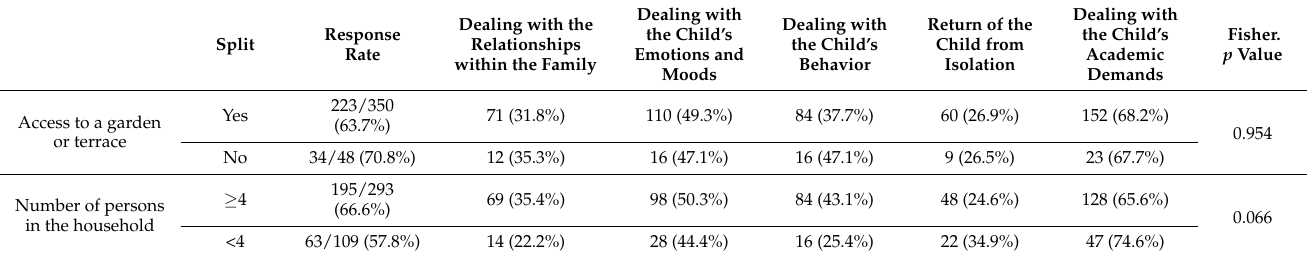
Table 3. Subgroup analysis based on a median split with respect to living conditions of the Waldorf families.